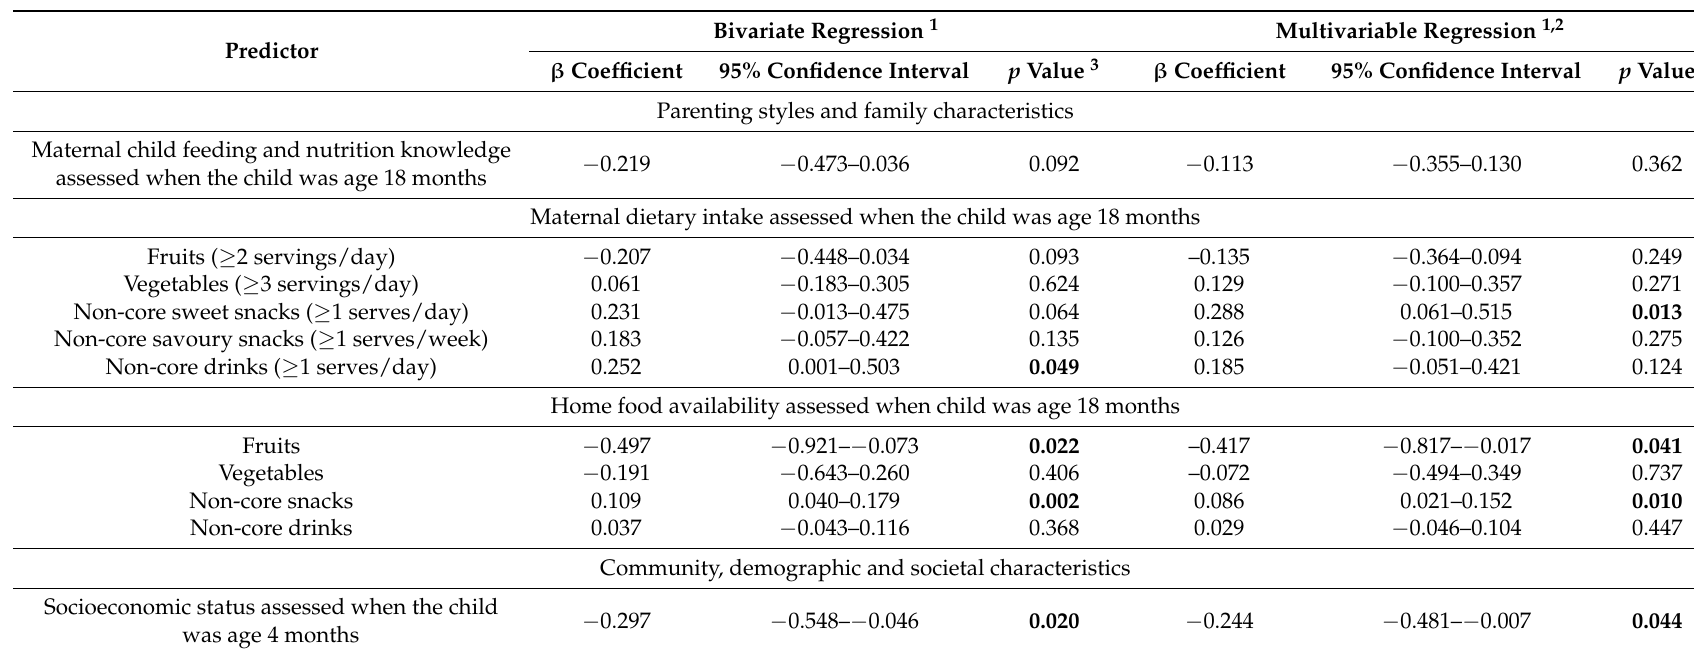
Table 4. Results of bivariate and multivariable linear regression analyses among children participating in the Melbourne InFANT Program ( n = 209) for the predictors and the dietary energy density variable dietary energy density from food and dairy beverages (DED food+dairy beverages